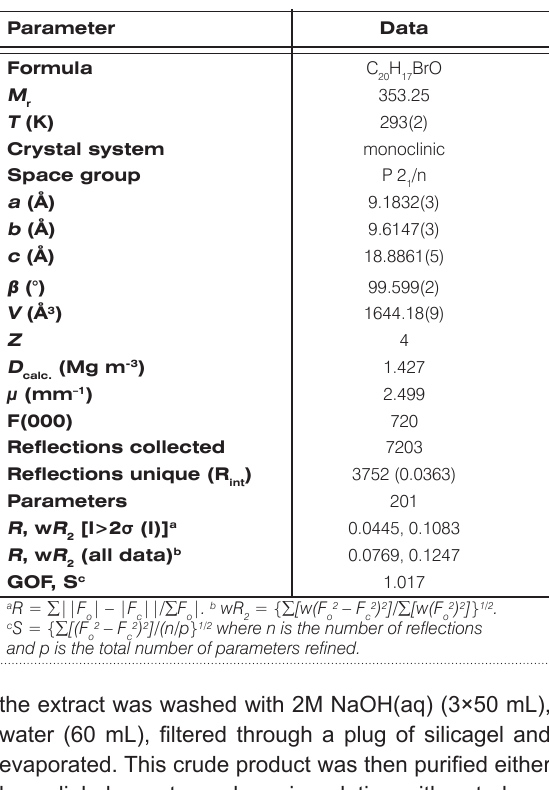
Table 1. Crystal data for 6d